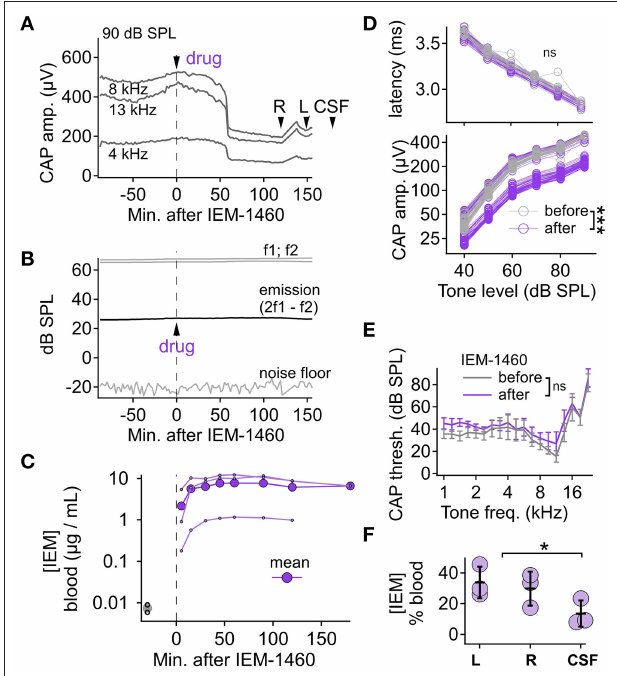
FIGURE 5 | Pharmacokinetic analysis and auditory functional measurements with systemic IEM-1460. (A) After baseline recording, IEM-1460 was injected (IP, 13.5 mg/kg) at time zero. CAP amplitude measured every 2min for 90 dB SPL tones at 4, 8, and 13kHz. At the end of the experiment, perilymph samples were taken from right (R) and left (L) cochleae before taking the CSF sample at times indicated. CAP N1-P1 amplitude decreased after drug injection. (B) Distortion product otoacoustic emissions (2f 1 -f 2 ) remained stable after drug injection. (C) Blood plasma levels of IEM-1460 increased to a sustained maximum within 30min of injection ( N = 3 animals). (D) CAP P1 latency was not significantly different ( p = 0.421, Wilcoxon, N = 4) after drug injection (upper) while CAP N1-P1 amplitude was significantly reduced ( p < 0.001, Wilcoxon, N = 4) (lower). (E) CAP threshold as a function of cochlear frequency was not significantly different ( p > 0.100 across all frequency comparisons, Mann-Whitney U , N = 4) before and after systemic injection of IEM-1460. (F) Perilymph and CSF levels, as % of IEM-1460 concentration in blood, were not significantly different from each other ( p = 0.670; Friedman test; N = 3). * p < 0.05; *** p < 0.001.